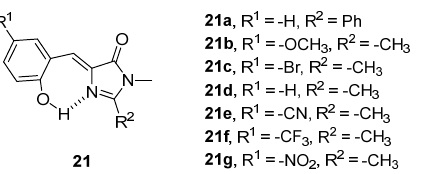
Figure 21. GFPc analogues with enhanced emission intensity due to the intramolecular hydrogen bond [36].